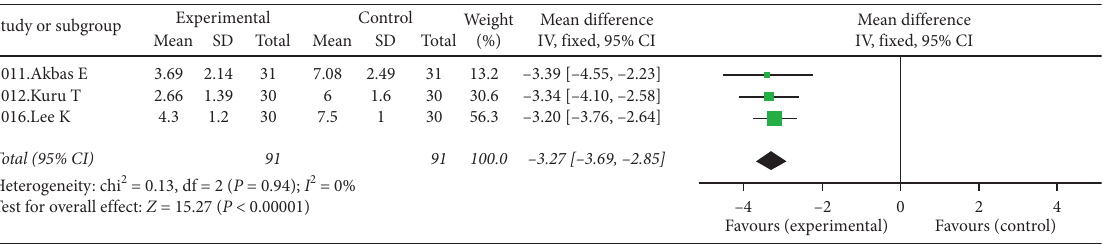
Figure 3: Effects of Kinesio Taping on chronic knee pain. Kinesio Taping combined with exercise program compared with exercise program